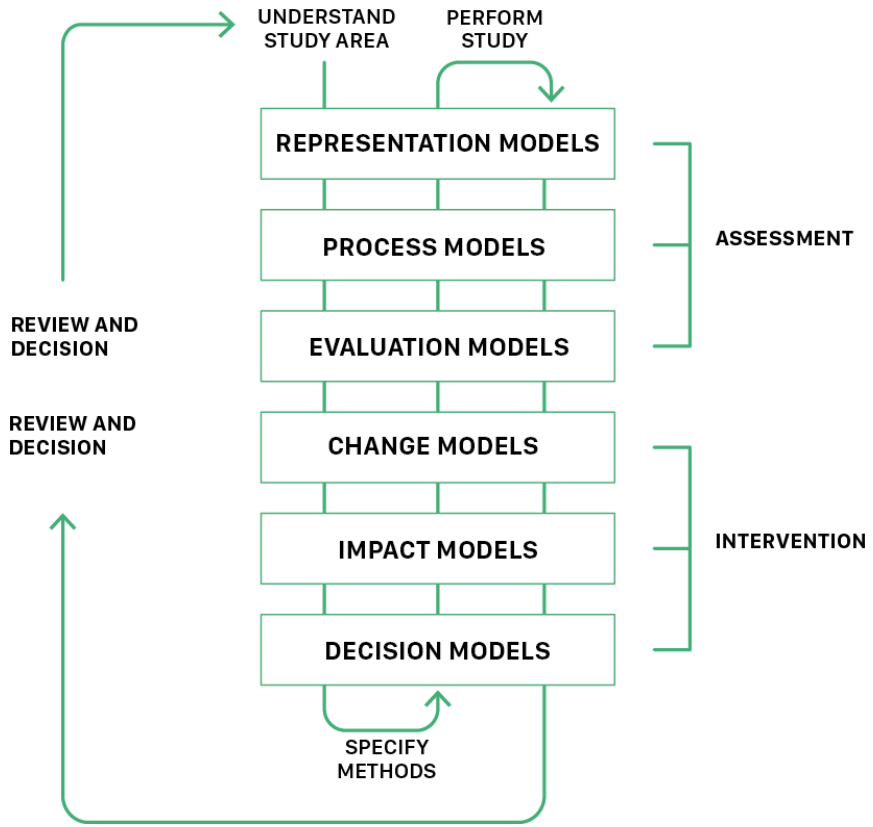
Figure 2. Geodesign Figure 2 . Geodesign framework.